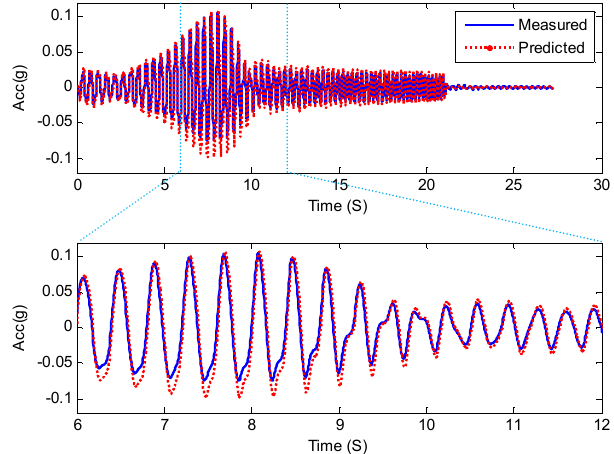
Figure 9. Model 3 ‐ ANFIS model identification for the acceleration behavior. Figure 9. Model 3-ANFIS model identification for the acceleration